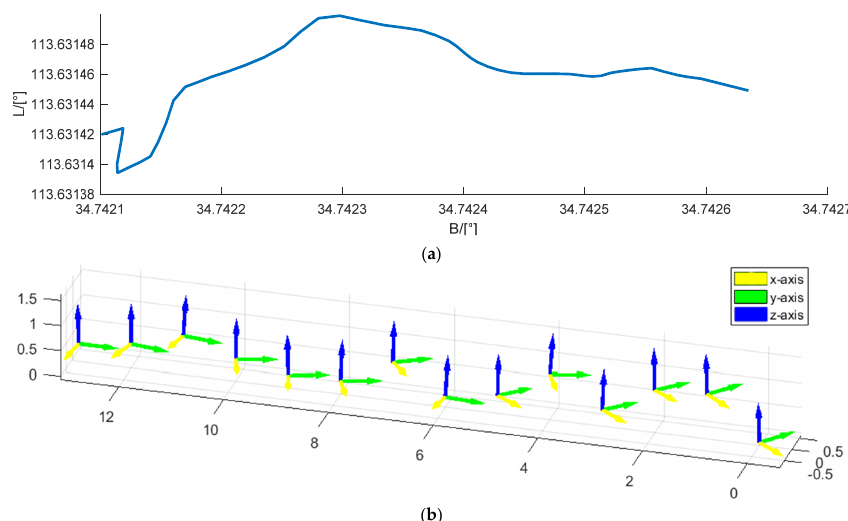
Figure 9. Experimental Results of Image Projection Texture Mapping. The Euler angles and GPS coordinates obtained from the gradient descent method attitude solution are imported into the browser, and Figure 10 shows the change in the attitude and position of the phone in the first 14 s.